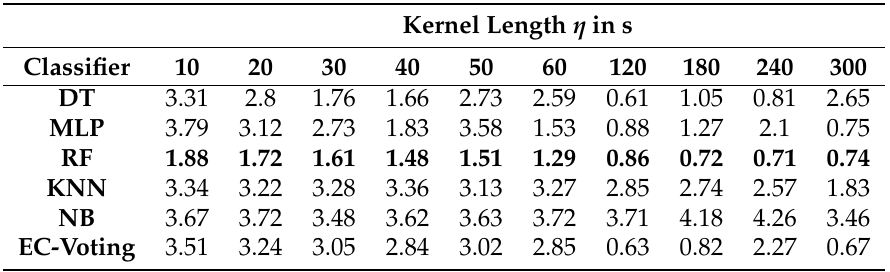
Table 3. Measure of standard deviation at different kernel length by different classifiers in Context 1, Scenario